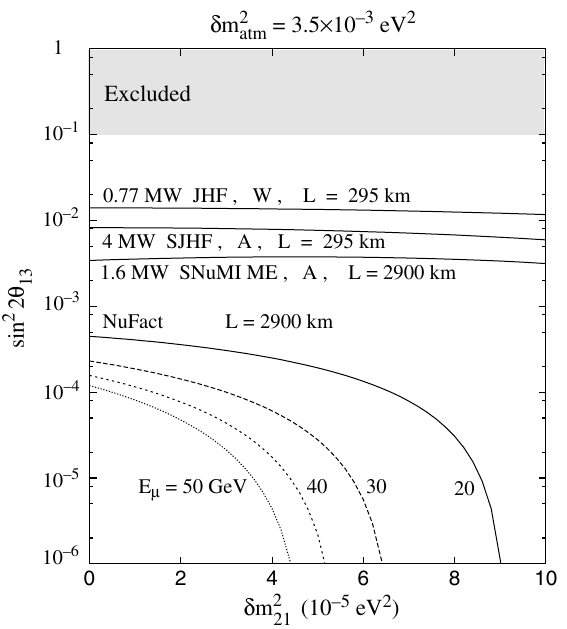
FIG. 9. Summary of the 3 (cid:31) level sensitivities for the obser- ! (cid:2) at various MW-scale superbeams (as indi- vation of (cid:2) (cid:3) e cated) with liquid-argon ‘‘A’’ and water-Cerenkov ‘‘W’’ detector parameters, and the observation of (cid:2) 50 kt detector at 20, 30, 40, and 50 GeV neutrino factories delivering 2 (cid:5) 10 20 muon decays in the beam-forming straight section. The limiting 3 (cid:31) contours are shown in the ; sin 2 2 (cid:5) ) plane. All curves correspond to 3 yr of run- ( (cid:6)m 2 13 21 ning. The grey shaded area is already excluded by current